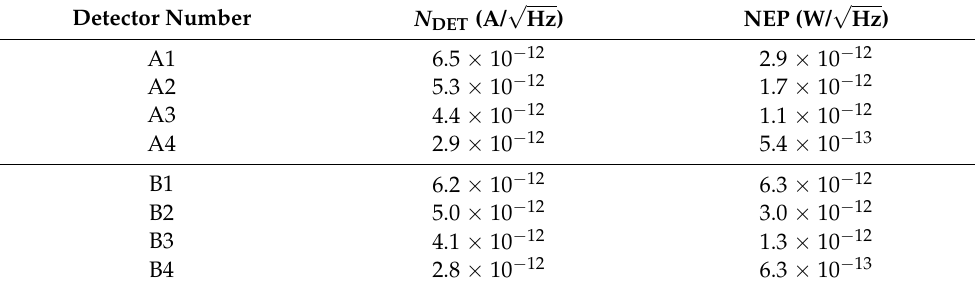
Table 2. NEPs of the